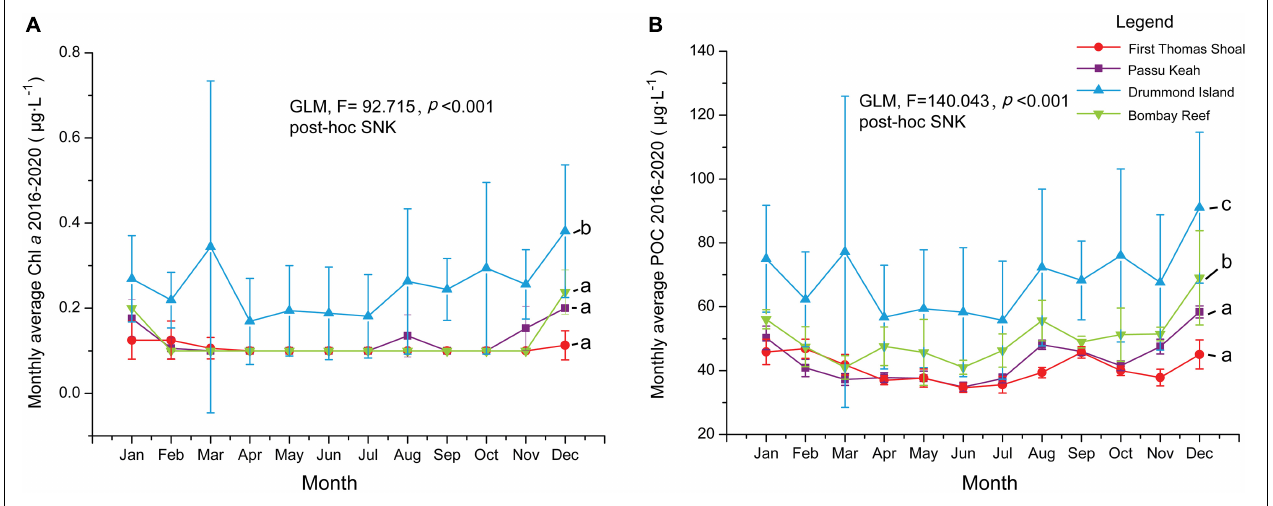
FIGURE 6 | Monthly average of chlorophyll a concentration (Chl a , µ g · L − 1 ) and particulate organic carbon concentration (POC, µ g · L − 1 ) from 2016 to 2020 for four coral reefs in the South China Sea (SCS). (A) Monthly average and standard deviations of Chl a in First Thomas Shoal (FTS), Passu Keah (PK), Drummond Island (DI), and Bombay Reef (BR). (B) Monthly average and standard deviations of POC in FTS, PK, DI, and BR. Chl a and POC differences among four coral habitats were analyzed by General Linear Model (GLM). Lowercase letters indicate post hoc comparisons (Student–Newman–Keuls test) (e.g., b, a, a, a) with the significant factors among coral